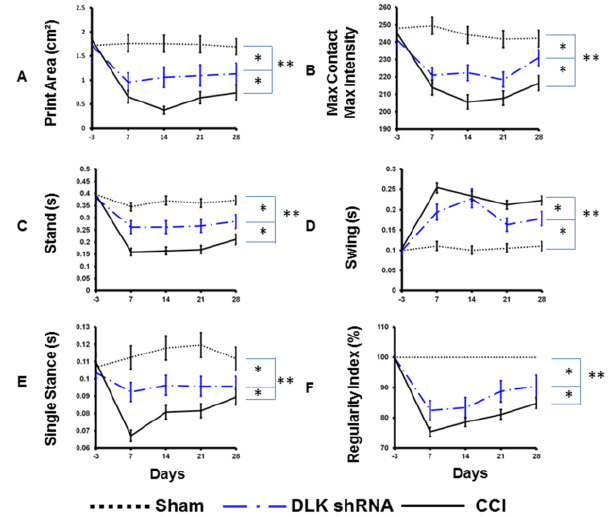
Figure 6. Representative data of the CatWalk XT parameters in CCI animals treated by DLK shRNA administrated 24 h after CCI. ( A ) Illustration of intensity of printed area in various treatment groups related to different time frames after operation. ( B ) Illustration of maximum contact maximum intensity in the various treatment groups related to different time frames after operation. ( C ) Illustration of stand phase in various treatment groups related to different time frames after operation. ( D ) Illustration of swing phase in various treatment groups related to different time frames. ( E ) Illustration of single stance in various treatment groups related to different time frames. ( F ) Illustration of regular index in the various treatment groups related to different time frames. * p < 0.05; ** p < 0.01.